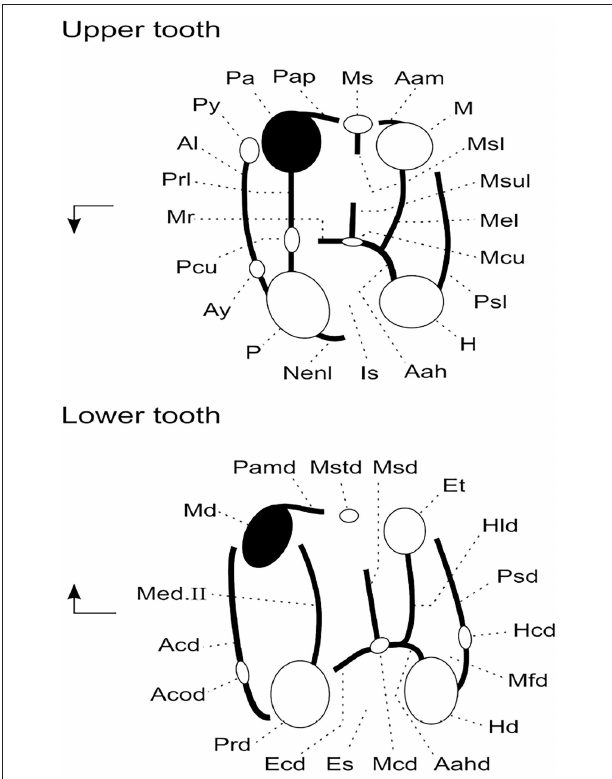
FIGURE 3 | Anatomical terminology used to describe rodent cheek teeth (adapted from Marivaux et al., 2011). Arrows point mesially and lingually to indicate orientation. Upper tooth abbreviations are as follows: Aah, anterior arm of hypocone; Aam, anterior arm of metacone; Al, anteroloph (or anterocingulum); Ay, anterostyle; H, hypocone; Is, internal sinus; M, metacone; Mcu, metaconule; Mel, metaloph; Mr, mure; Ms, mesostyle; Msl, mesoloph; Msul, mesolophule; Nenl, neo-endoloph; P, protocone; Pa, paracone; Pap, posterior arm of paracone; Pcu, protoconule; Prl, protoloph; Psl,